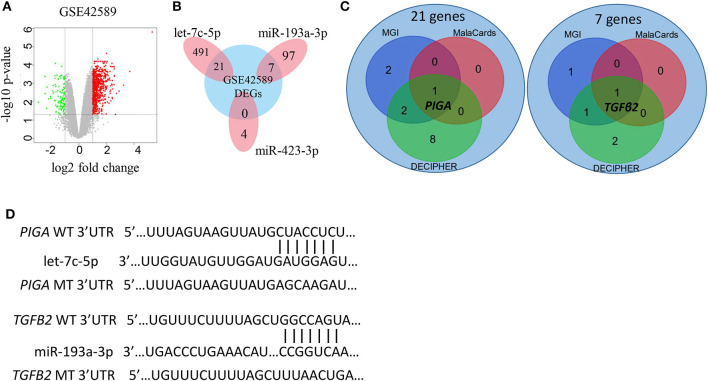
Selection of potential miRNA target genes. (A) Volcano plot of differentially expressed genes (DEGs) in GSE42589. (B) Target genes of the three miRNAs intersected with DEGs in GSE42589, respectively. A total of 28 genes are considered as susceptible genes for non-syndromic cleft lip with or without cleft palate. (C) Distribution of the 21 and 7 susceptible genes for non-syndromic cleft lip with or without cleft palate in three databases. MGI, Mouse Genome Informatics database; MalaCards, A Comprehensive Automatically-Mined Database of Human Diseases; DECIPHER, DatabasE of genomiC varIation and Phenotype in Humans using Ensembl Resources. (D) The predicted let-7c-5p and miR-193a-3p binding sites in the WT of 3′-UTR (untranslated region) of PIGA and TGFB2, as well as the MT of PIGA and TGFB2. WT, wide type; MT, mutation type.